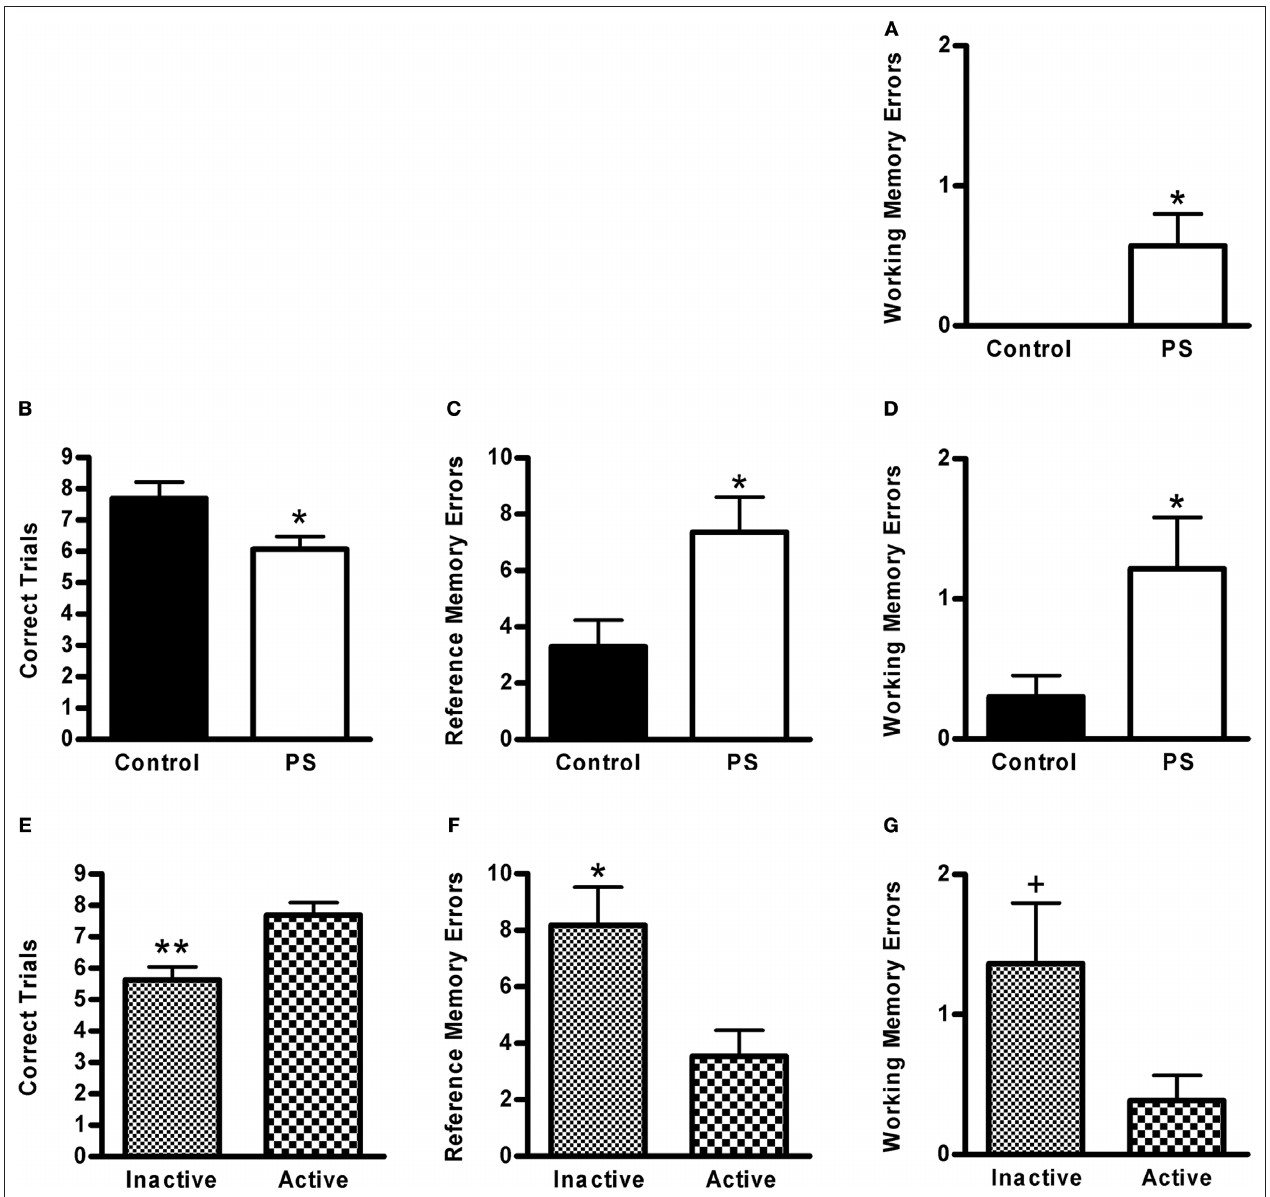
Figure 7 | Visual discrimination: (A) Prenatally stressed (PS) male rats committed more working memory errors than controls (* p < 0.04) on a memory retention test conducted 2 weeks following training. (B) Prenatally stressed male rats also had fewer correct trials (* p < 0.02), (C) more reference memory errors (* p < 0.02), and (D) more working memory errors than controls